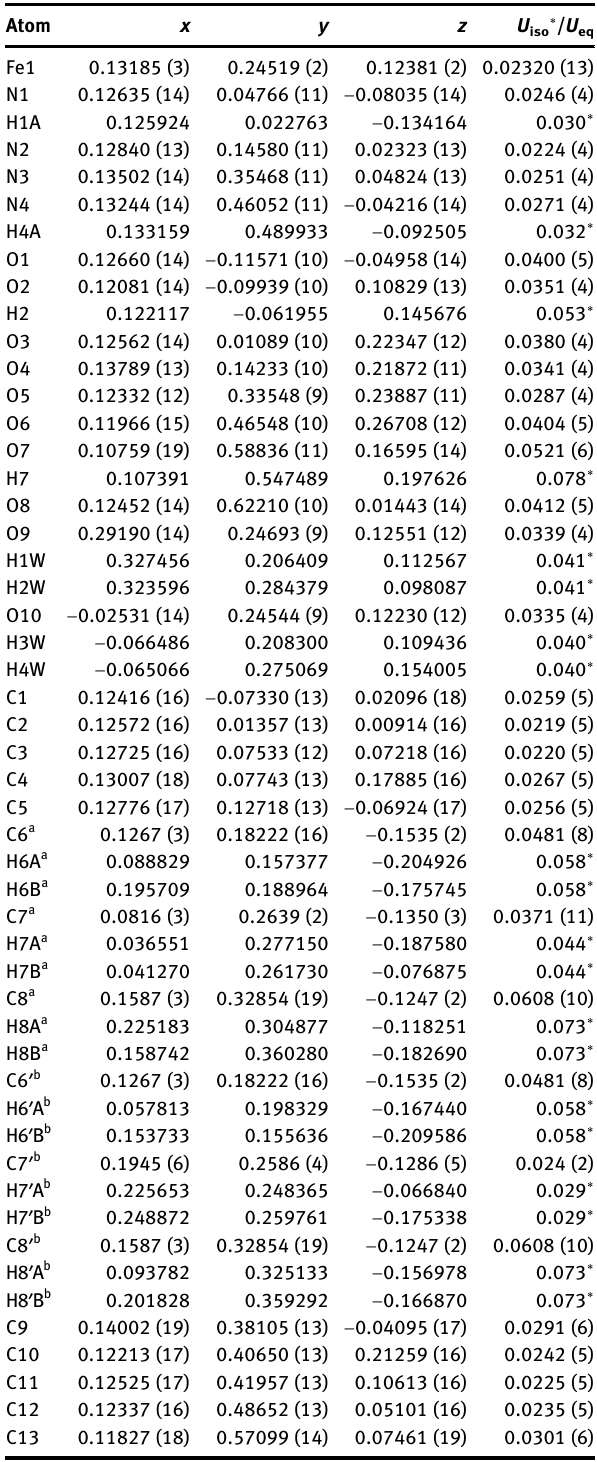
Table  : Fractional atomic coordinates and isotropic or equivalent isotropic displacement parameters (Å 